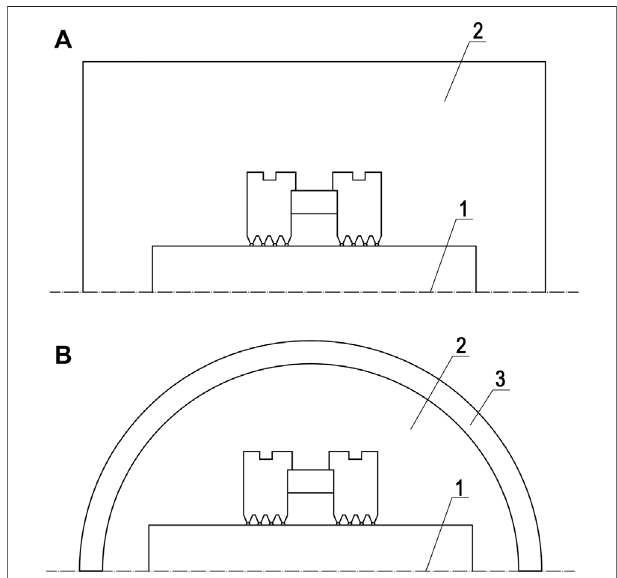
FIGURE 3 | Geometric modeling of an MFS structure with (A) rectangular air domain (B) circular air domain with in fi nite elements (1-axis of symmetry, 2-air domain, and 3-in fi nite